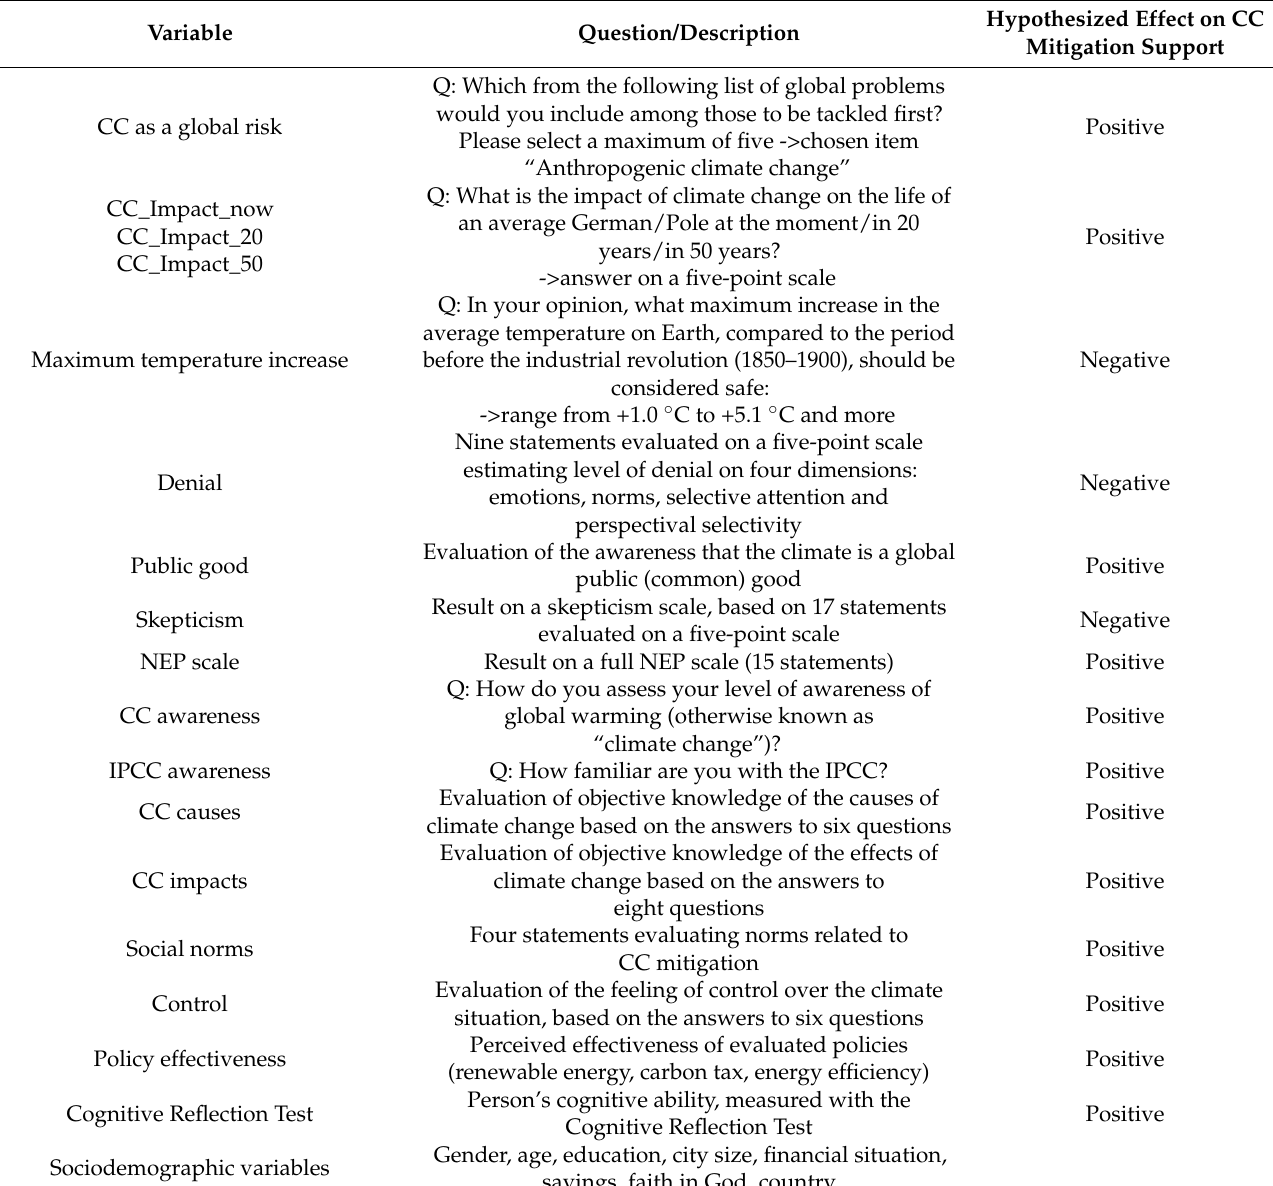
Table 2. Variables hypothesized to determine likelihood of supporting climate change (CC)